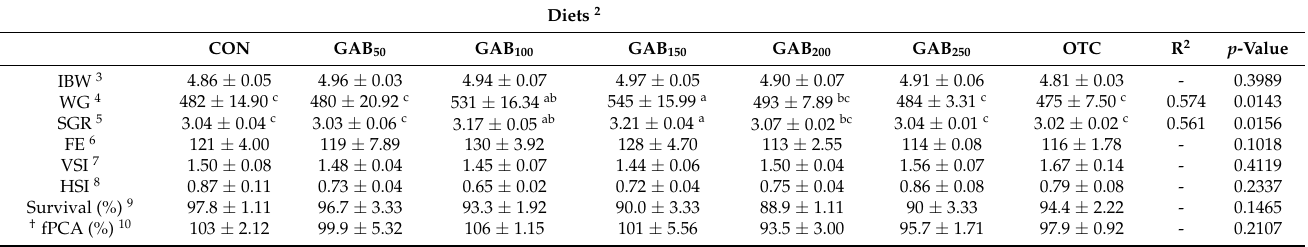
Table 2. Growth performance, feed efficiency, organosomatic indices, survival, and fPCA 1 .